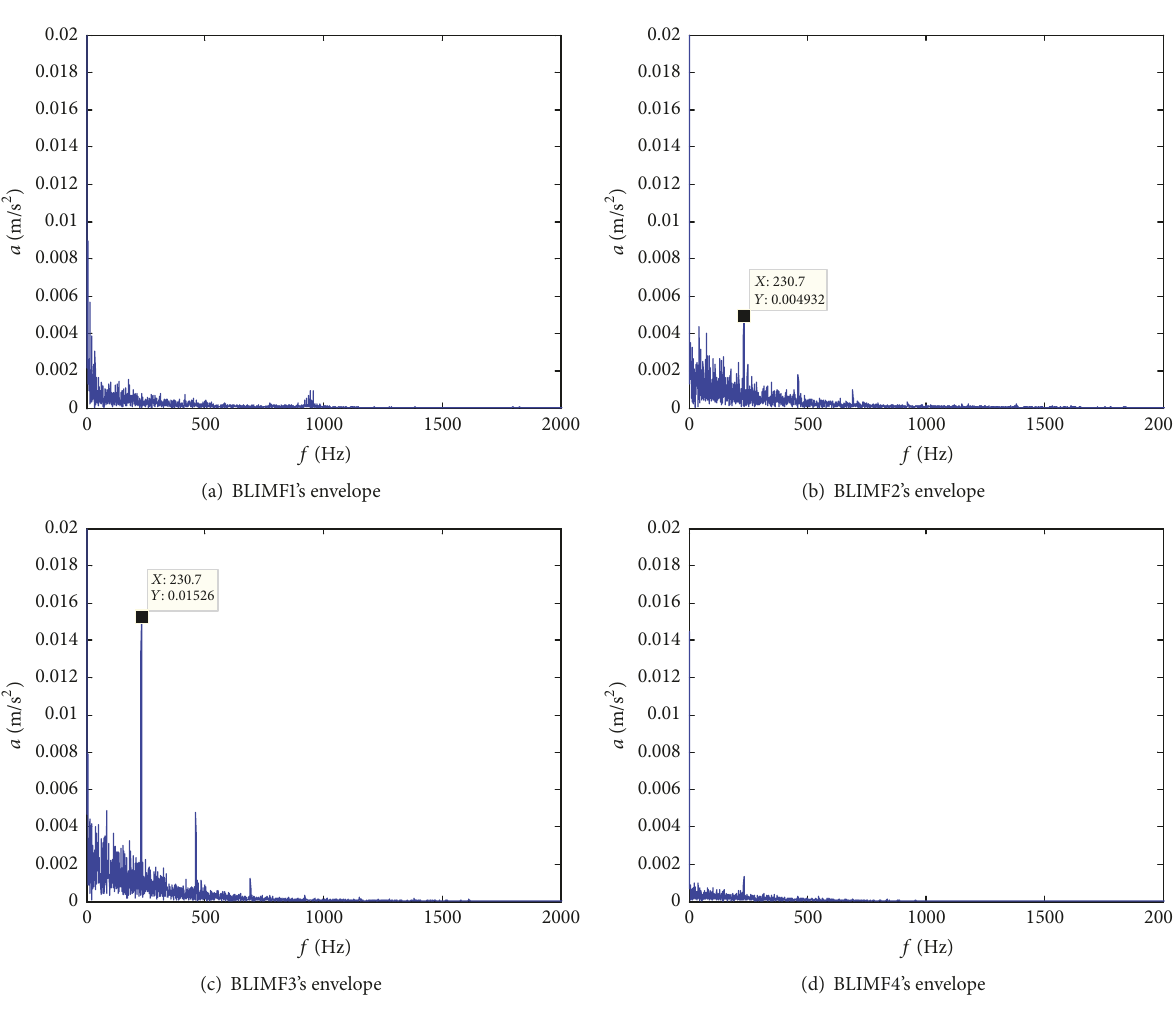
Figure 7: The envelope spectrum of BLIMF1 to BLIMF4 of #600.